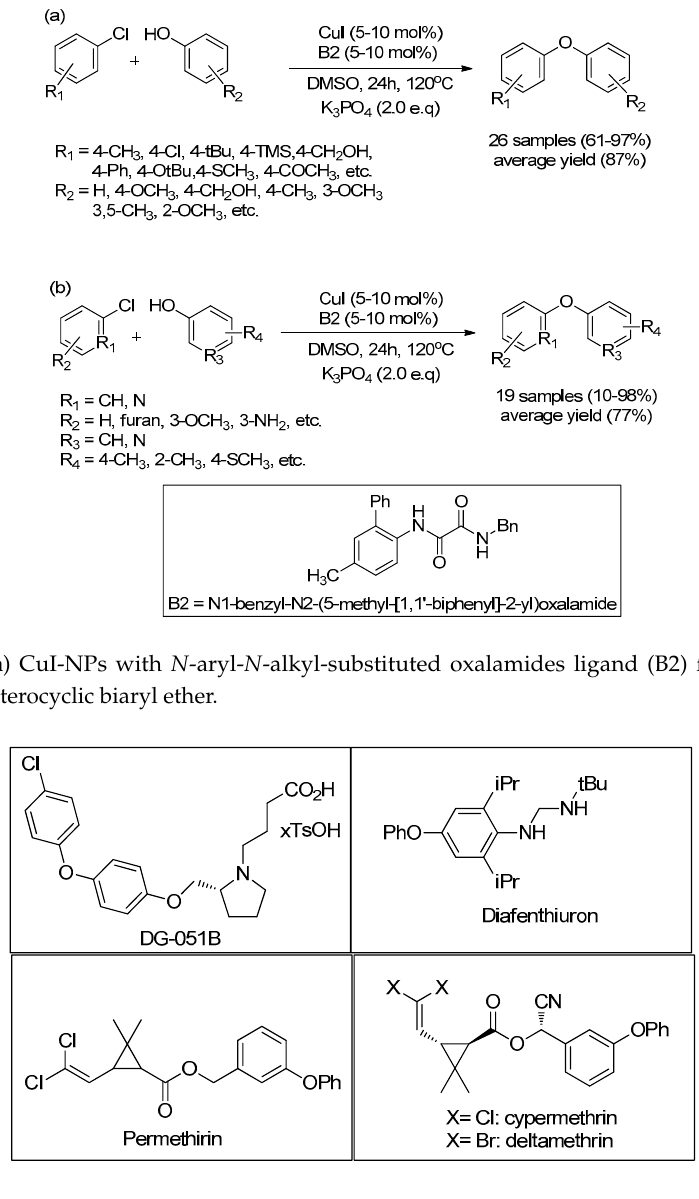
Figure 12. ( 1 ) 2-pyrazol-1-ylpyridine ligand (B3); ( 2 ) 2-pyrazol-1-ylpyridine ligand with CuI; ( 3 ) structures of monomeric complexes of a 2-pyrazol-1-ylpyridine ligand with CuI. In this study, a non-radical mechanism was proposed in the Ullmann-type C-O bond formation reaction. Initially, pyrazole ligand makes a coordination complex with copper ion. When the reaction is started, oxidative addition (OA) will first occur, in which the Cu + undergoes OA with aryl halide to form Cu 3+ intermediate A. Then, the phenoxide undergoes nucleophilic substitution (NS) and through the reductive elimination (RE) biaryl ether is generated and the Cu 3+ reduced o Cu + . The proposed ligand B3, which has N py and N pz , play a different role in the reaction, where N py is more likely the electron-rich copper center and encourages the coordination of aryl halide. N pz play the role to lower and speed up the NS and RE step. This mechanism corresponds to the steric effect of the substituent at ortho-position in aryl halide rather than phenol due to an aromatic group of the former binding straight to the copper atom in the intermediate A (Scheme 42b), and Cu-O